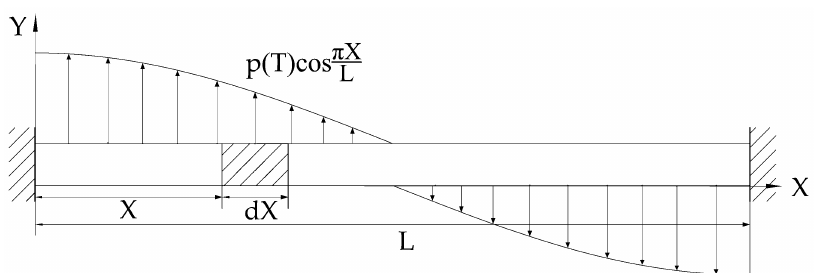
Figure 1. Sketch of the microbeam.